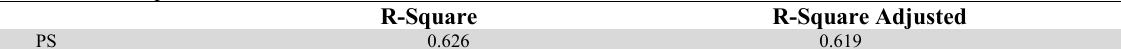
Original Standard T Statistics